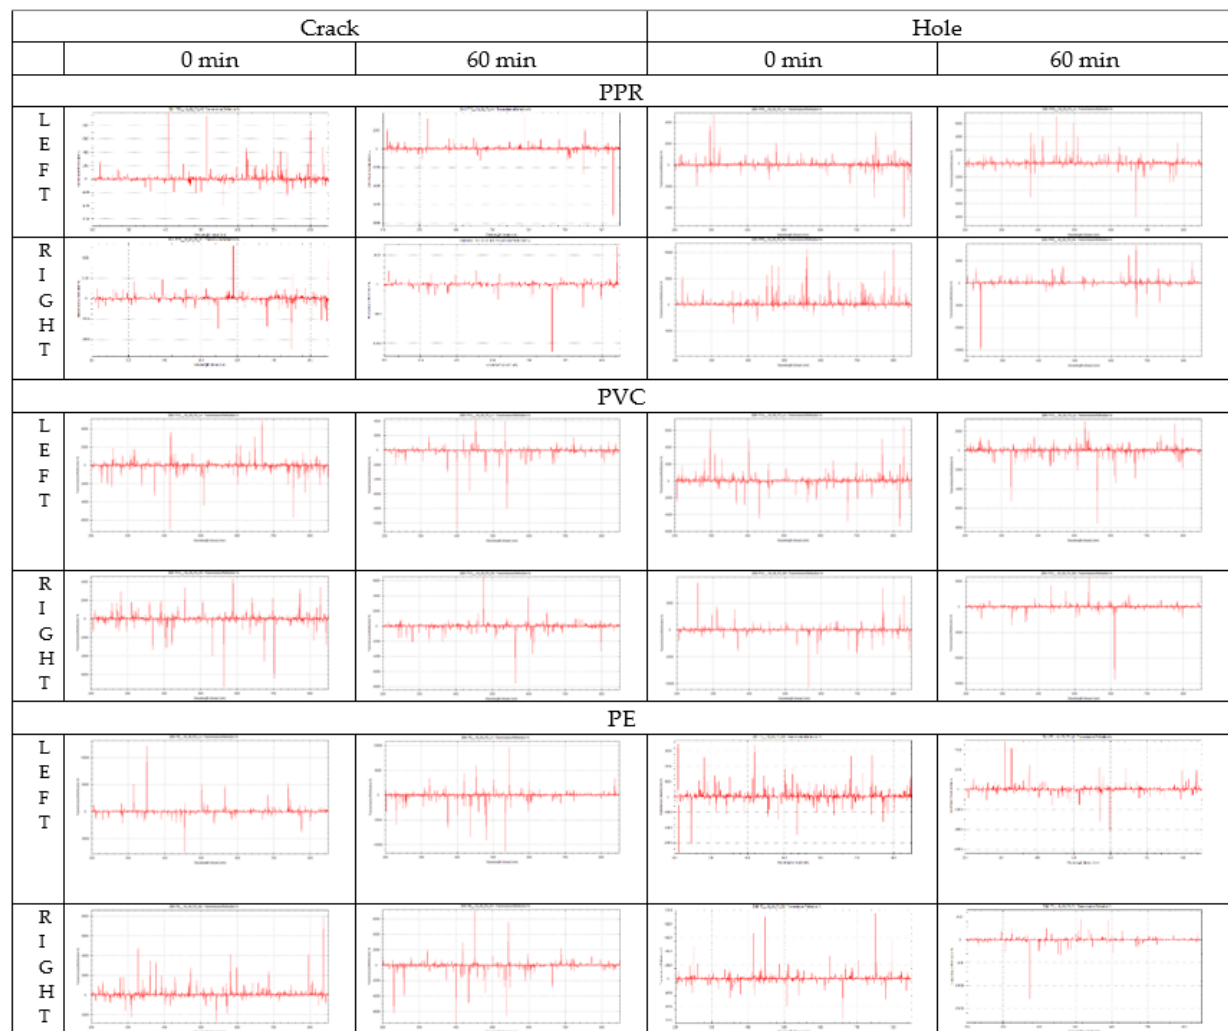
Figure 16. Spectrometer reflectance obtained from the PE pipe with a crack (right) at 2% moisture content.